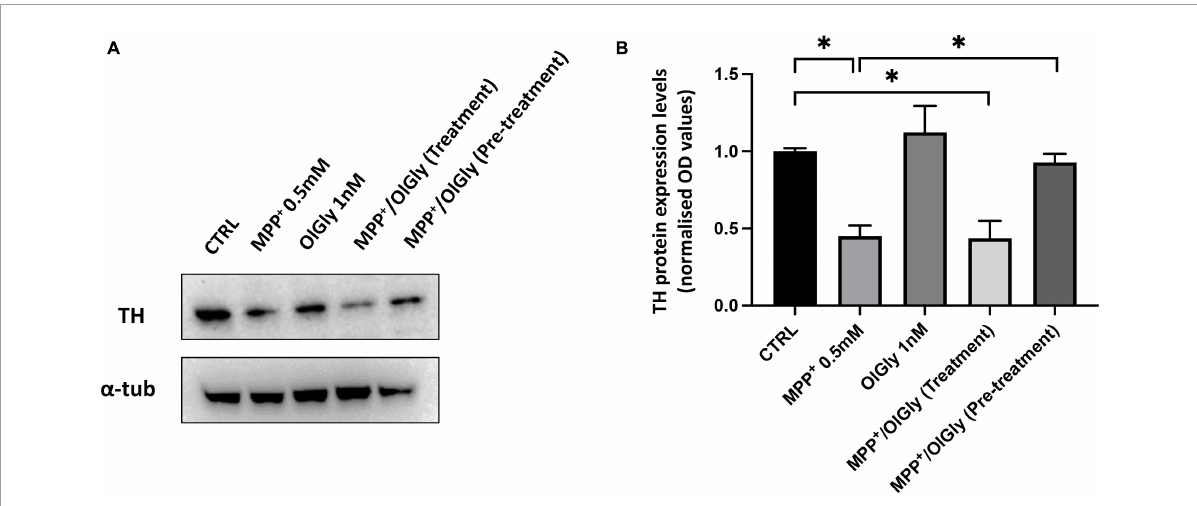
FIGURE6 Expression of TH in differentiated SH-SY5Y cells. (A) Western blots of SH-SY5Y cell proteins with or without treatment with MPP + , OlGly, MPP + /OlGly (simultaneous treatment), and MPP + /OlGly (pre-treatment) probed with anti-TH-specific antibody. (B) Quantification of the data shown in (A) . The bars represent the ratio of anti-TH vs. α -tubulin expression. Data are expressed after normalization to the ratio OD TH/OD-tubulin in each group. Data are represented as mean ± SEM ( n = 3). One-way ANOVA has been used for statistical analysis. Asterisks denote values statistically significant ( p <